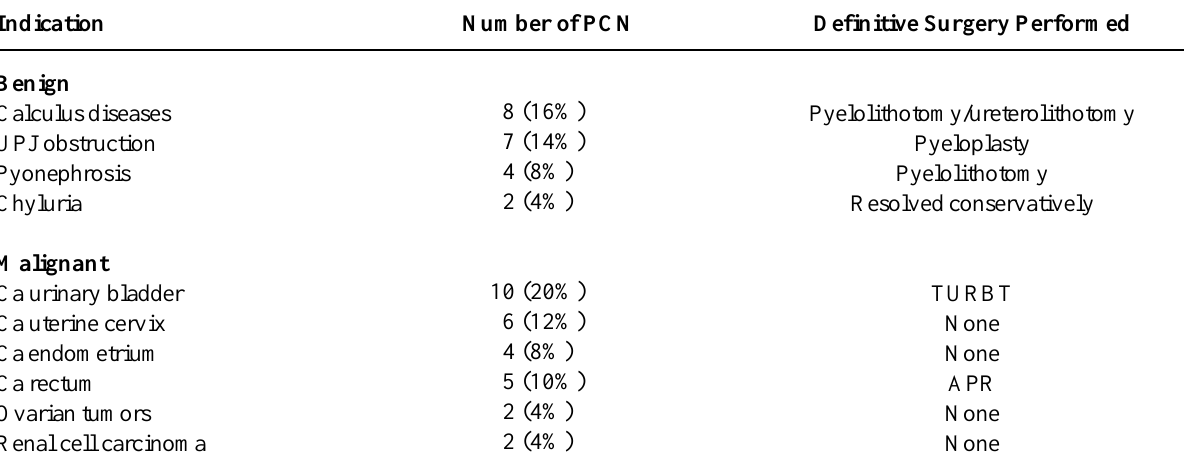
Table 1 – Distribution of indications for percutaneous nephrostomy (PCN).